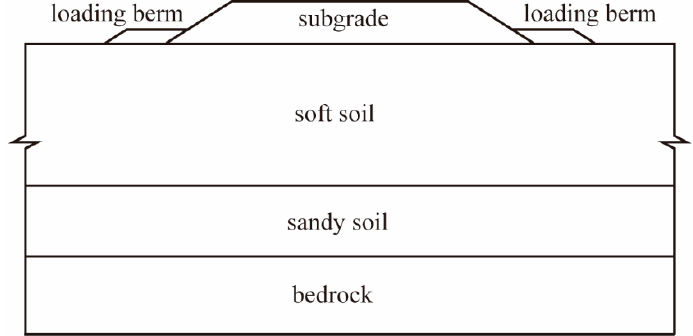
Figure 1. Schematic diagram of loading berm.